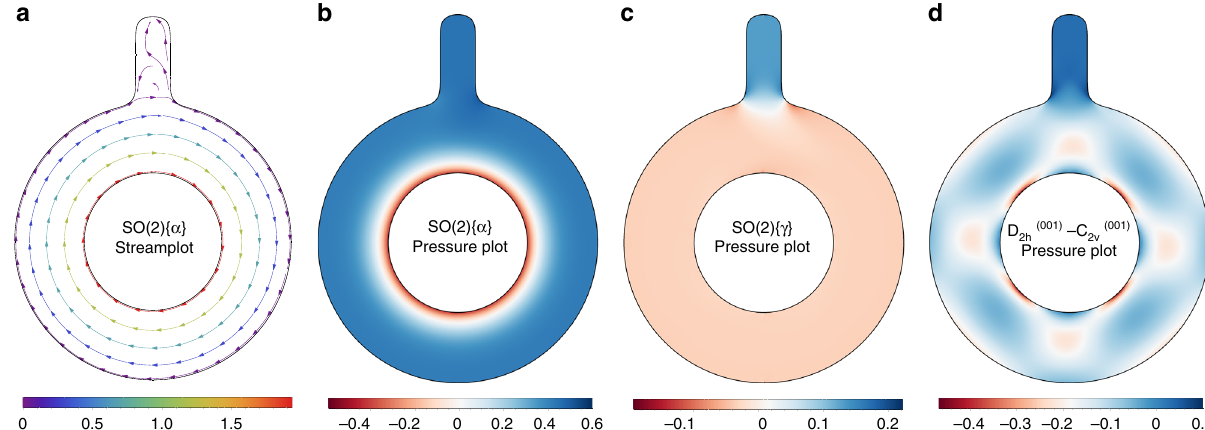
Fig. 2 Proposed setup to quantify the effect of viscosity tensor asymmetry and Hall coef fi cient. Steady-state a streamplot and b pressure plot using viscosity tensor SO(2){ α }. c Difference in steady-state pressure between viscosity tensor SO(2){ α } and the same with additional stress objectivity- breaking terms (SO(2){ γ }). The asymmetry introduces an additional pressure-like contribution, which can be directly measured. d Difference in steady- state pressure between the D 2 h and C 2 v viscosity tensors along the ab plane, showing a similar pressure drop in the gauge, despite the anisotropic behavior inside the annulus. Color scales indicate the magnitude of the velocity vector fi eld ( a ) and pressure fi eld ( b – d To quantify the pressure difference between SO(2){ α } and SO (2){ γ }, note that the pressure is fi xed to zero at a point p , the bottom of the annulus domain. The pressure in the gauge may be